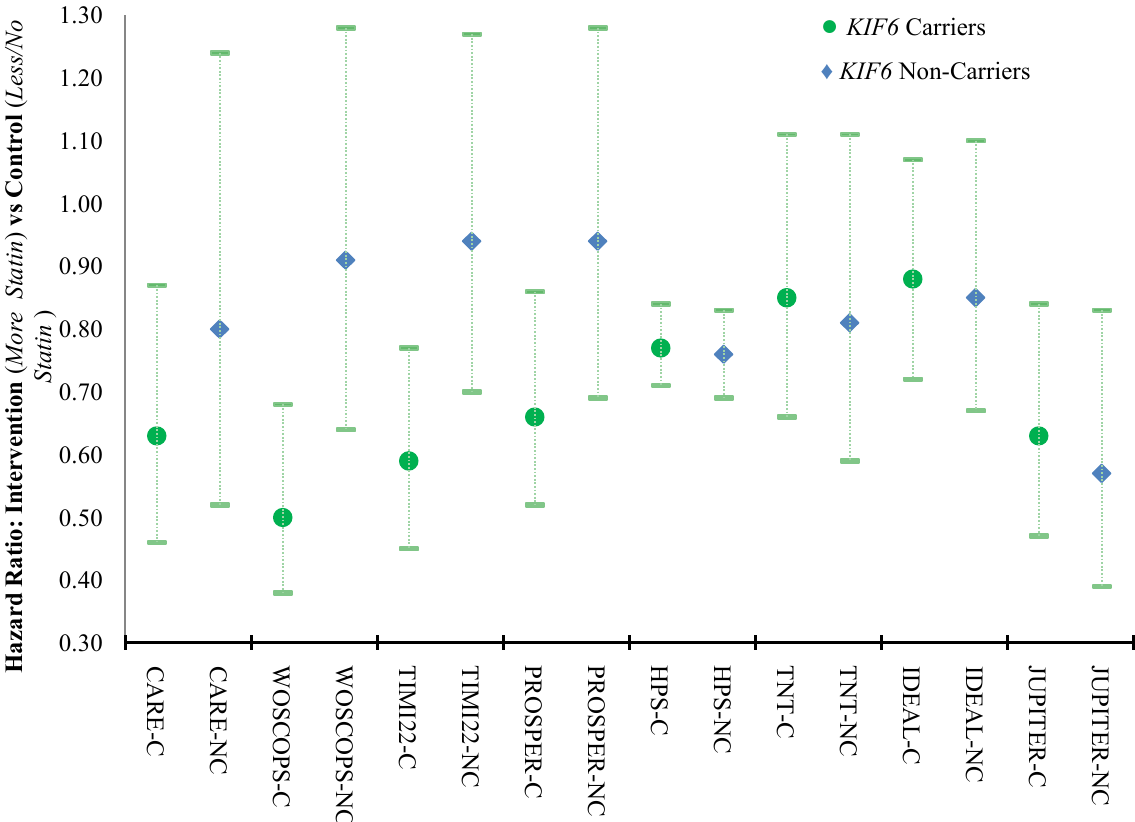
Figure 1. KIF6 and Statin